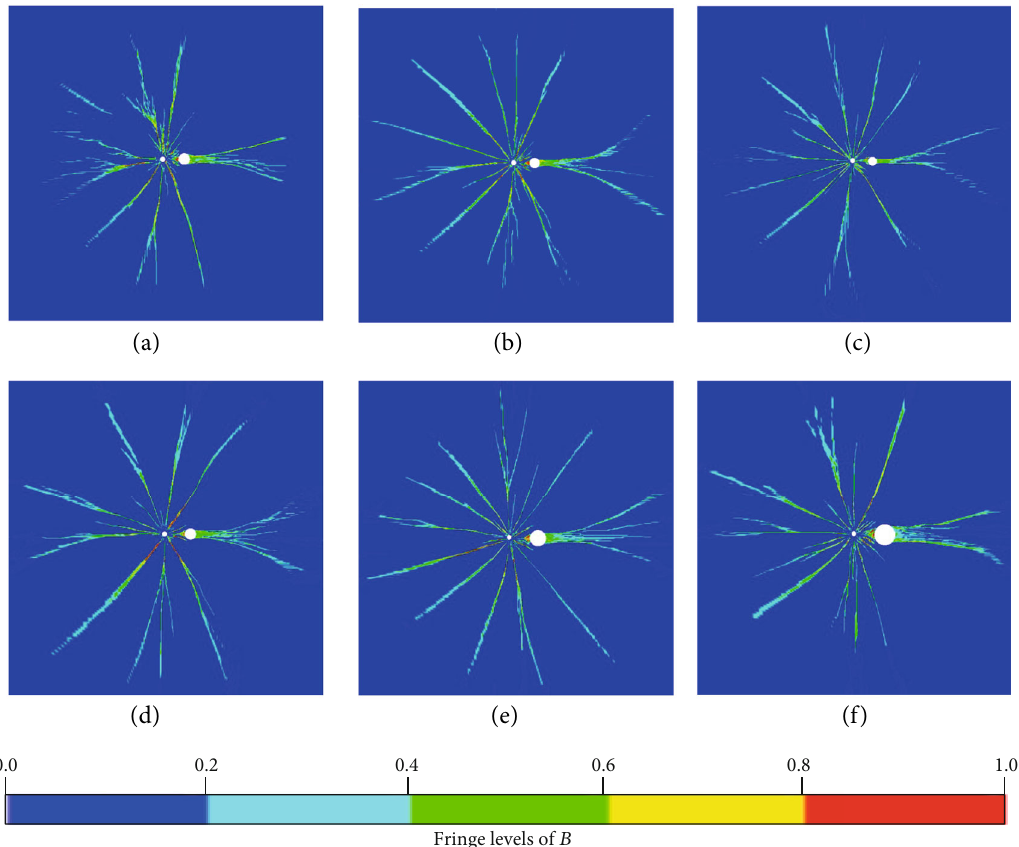
Figure 7: Tension damage of prime cut blasting under di ff erent diameters of the empty hole: (a) scheme 3, (b) scheme 7, (c) scheme 8, (d) scheme 5, (e) scheme 9, and (f) scheme